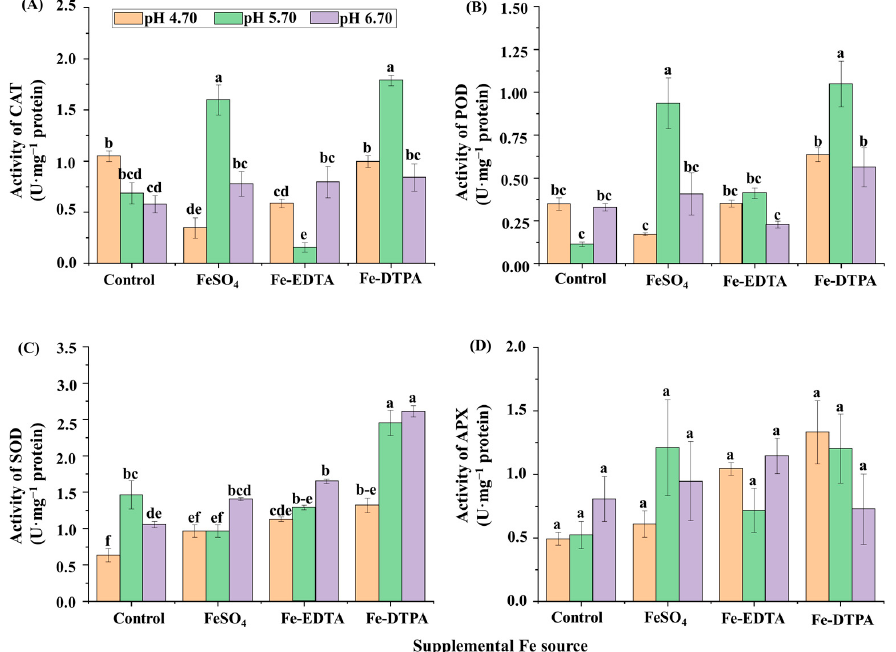
Figure 3. The activities of CAT ( A ), POD ( B ), SOD ( C ), and APX ( D ) in S. commixta after 6 weeks of culture. Lowercase letters indicate significant differences by the Duncan’s multiple range test at p ≤ 0.05.